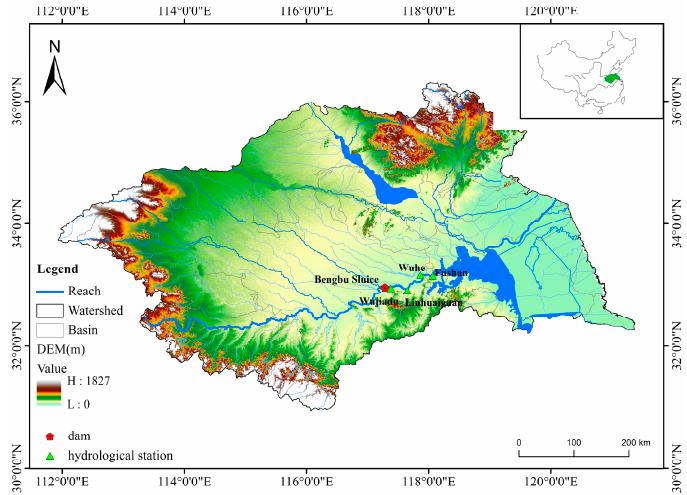
Figure 1. Geographical location of the Huai River.